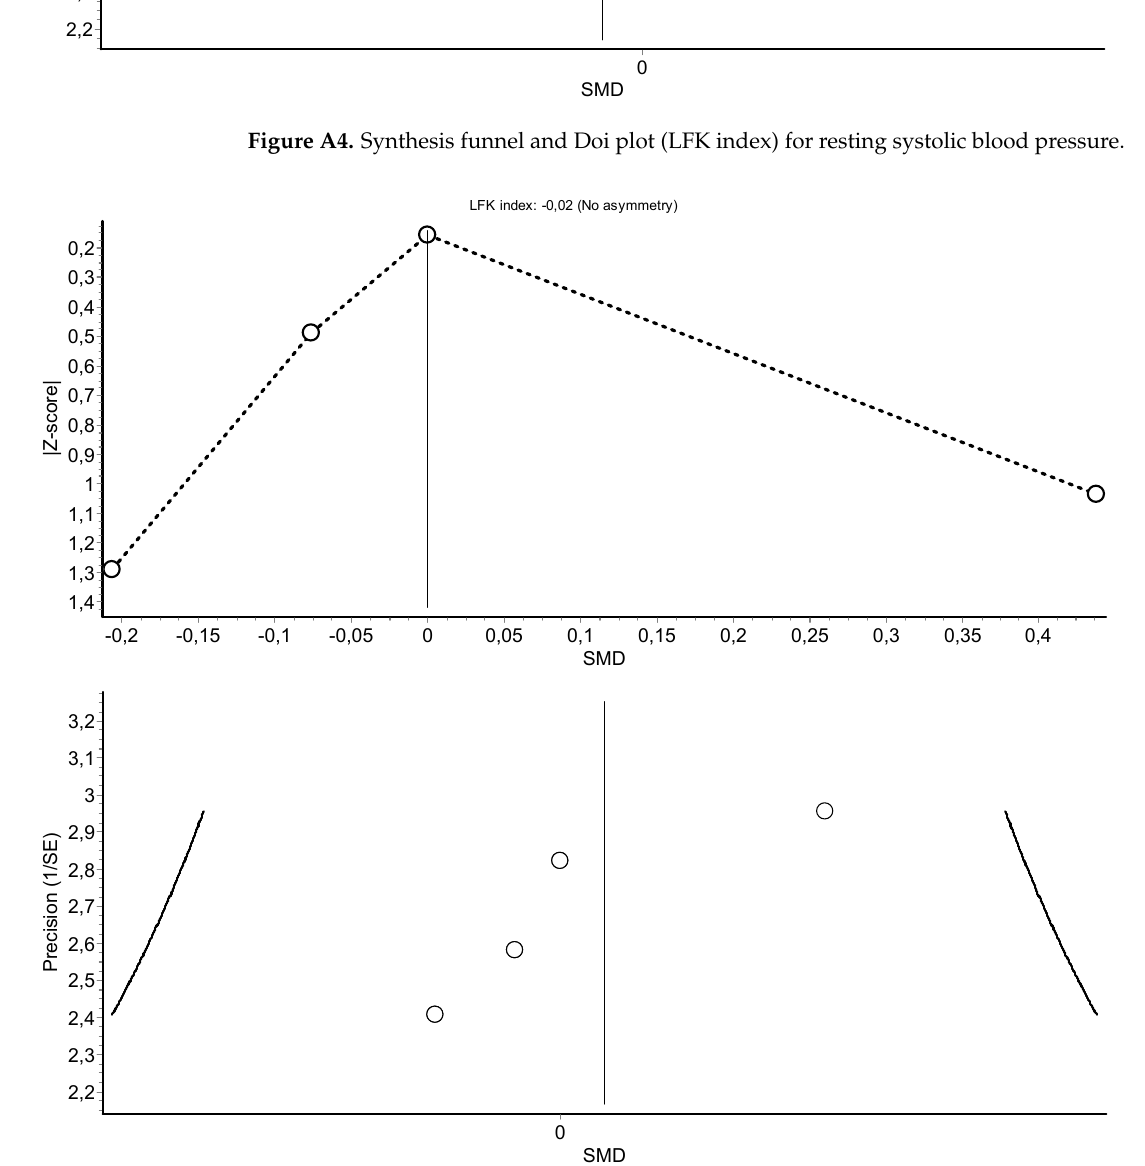
Figure A5. Synthesis funnel and Doi plot (LFK index) for resting diastolic blood pressure.